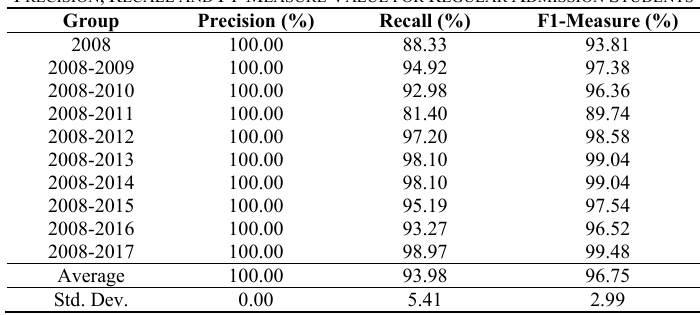
TABLE 13 P RECISION , R ECALL AND F1-M EASURE V ALUE FOR R EGULAR A DMISSION S